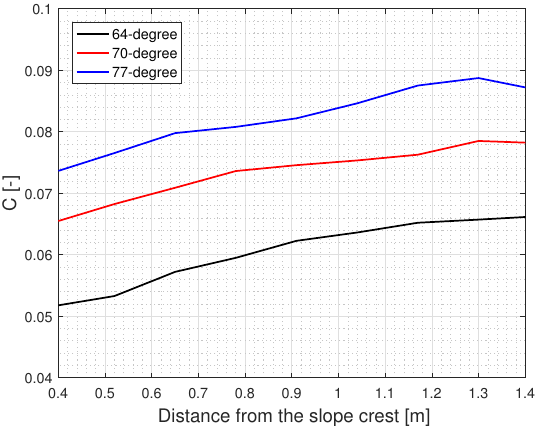
Figure 11. Spatial development of the layer-averaged concentration C along the breach